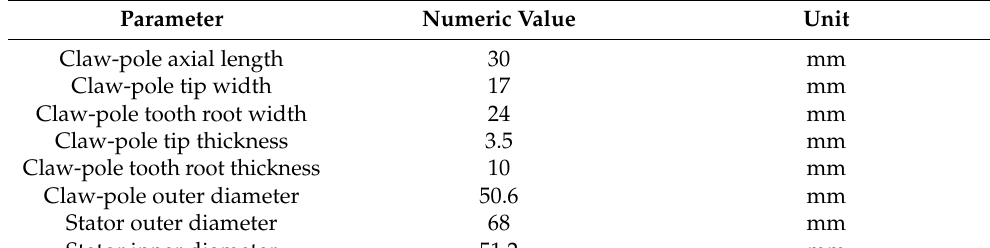
Table 1. Reverse claw-pole electrically excited generator part of the structural parameters.